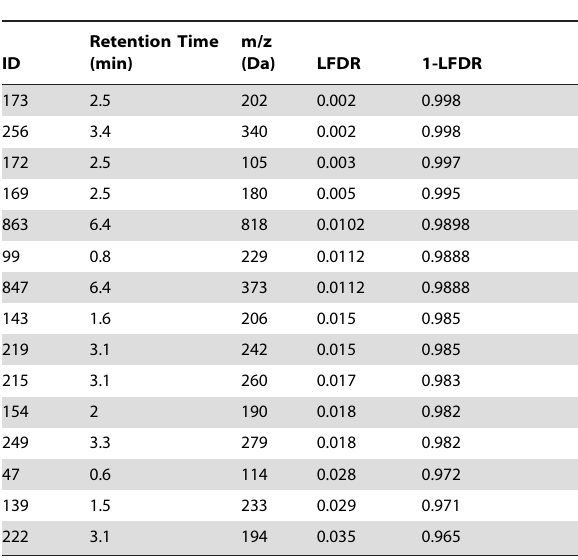
Table 1. LFDRs for the GF-treated group and the healthy control group at different retention